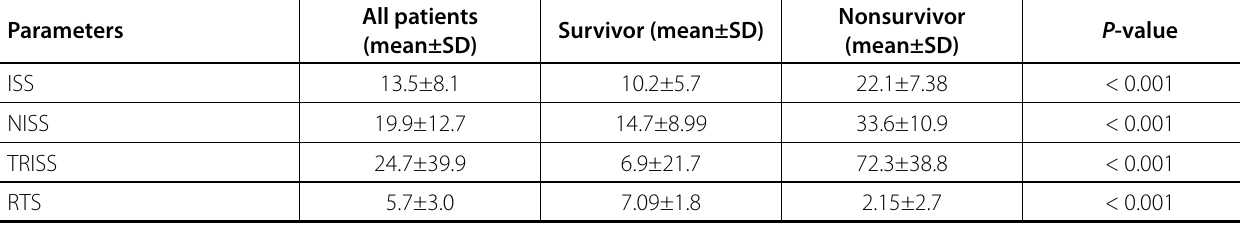
Table 4 . Mean scores of all cardiovascular trauma patients, survivors, and nonsurvivors. Parameters